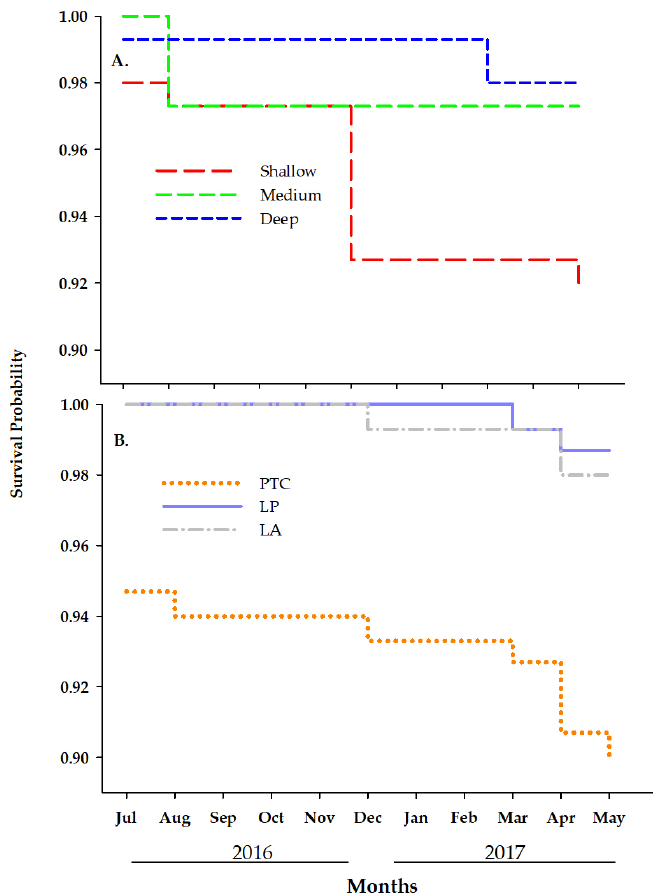
Figure 6. Probability of surviving of Acropora cervicornis fragments across the 11-month study period by depths ( A ) and site of collection ( B ): Luis Peña (LP), La Ahogá (LA) and Punta Tamarindo Chico (PTC). by depths ( A ) and site of collection ( B ): Luis Peña (LP), La Ahog á (LA) and Punta Tamarindo Chico